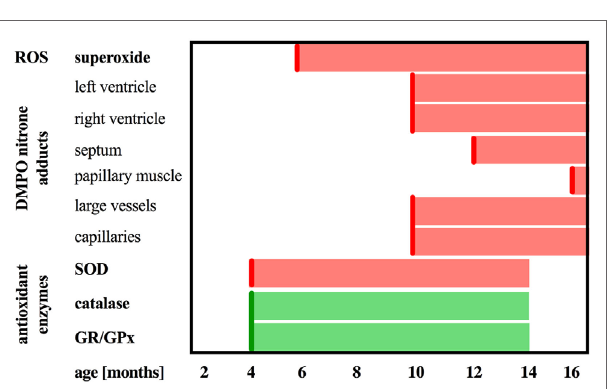
FigUre 9 | Summary of DMPO immuno-spin trapping results in relation to reactive oxygen species generation and antioxidant activity in Tg α q*44 mice. Scheme representing the sequence of events in terms of upregulation of catalase and glutathione reductase and peroxidase (GR/GPx), downregulation of superoxide dismutase (SOD) activity, increased superoxide production in the heart, followed by oxidative modifications in the heart in the relation to the age of Tg α q*44